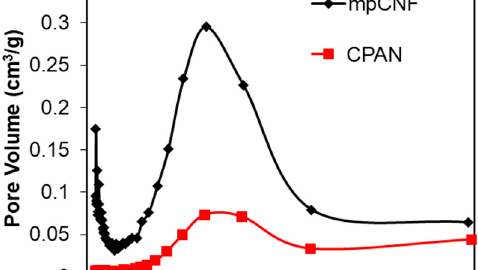
Figure 10. Comparison of pore-size distribution of mpCNF and CPAN assessed by the BET method.